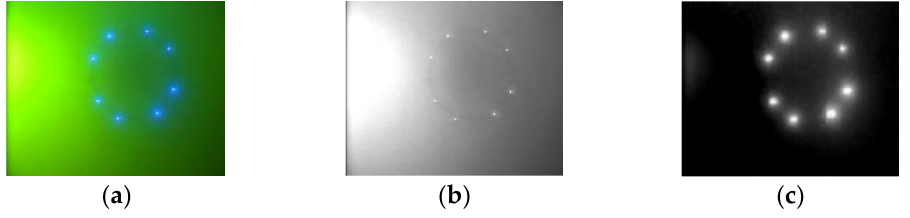
Figure 2. Guidance image: ( a ) original image; ( b ) green component G of the guidance image; ( c ) blue component B of the guidance image.